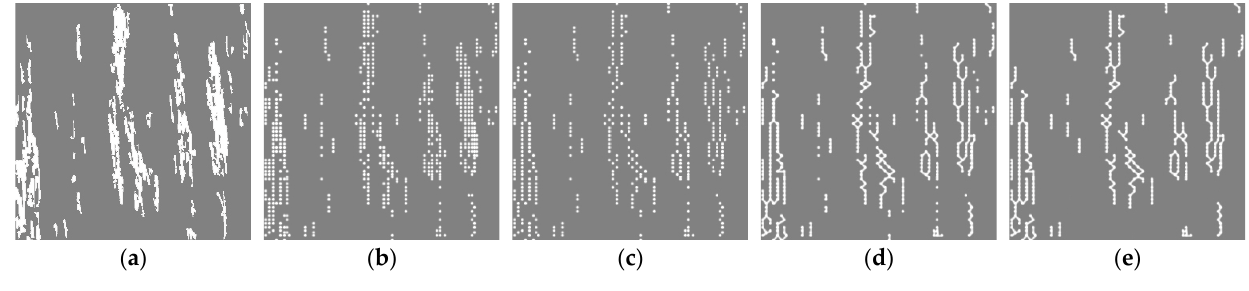
Figure 3. Creation process of feature graphic based on image feature map: ( a ) image feature map; ( b ) key point feature map; ( c ) sampling point map; ( d ) feature graphic; ( e ) clear graphic map.